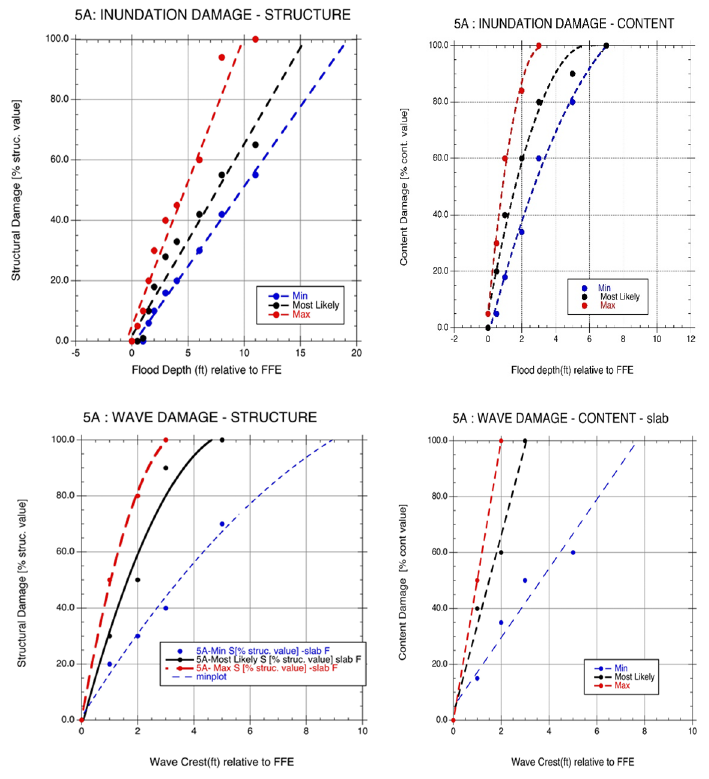
Figure 2. ACOE NACCS [5] damage curves for structure and content for inundation and waves for Prototype 5A, single story building without basement. Minimum, most likely, and maximum curves are provided for each. All plots are percent damage vs. elevation relative to finished floor elevation (FFE).